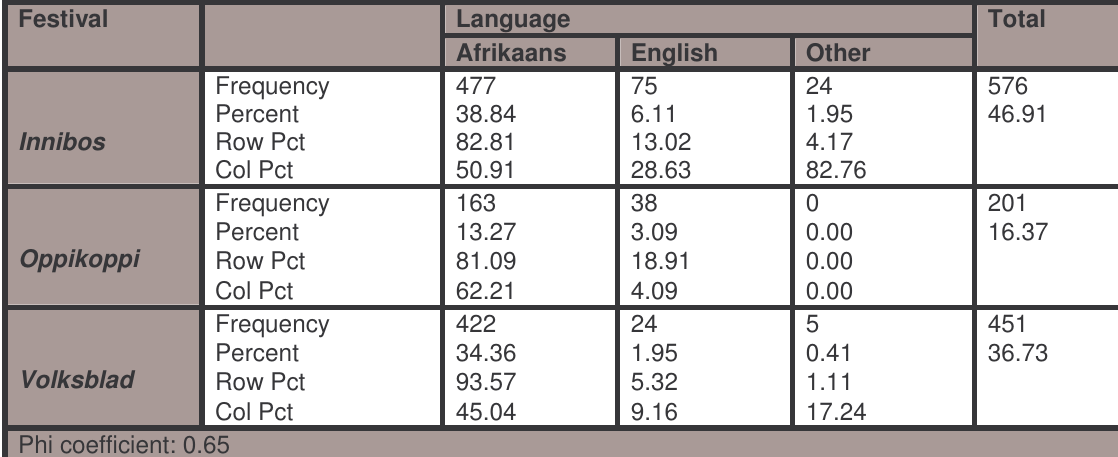
Table 5: Language and festivals